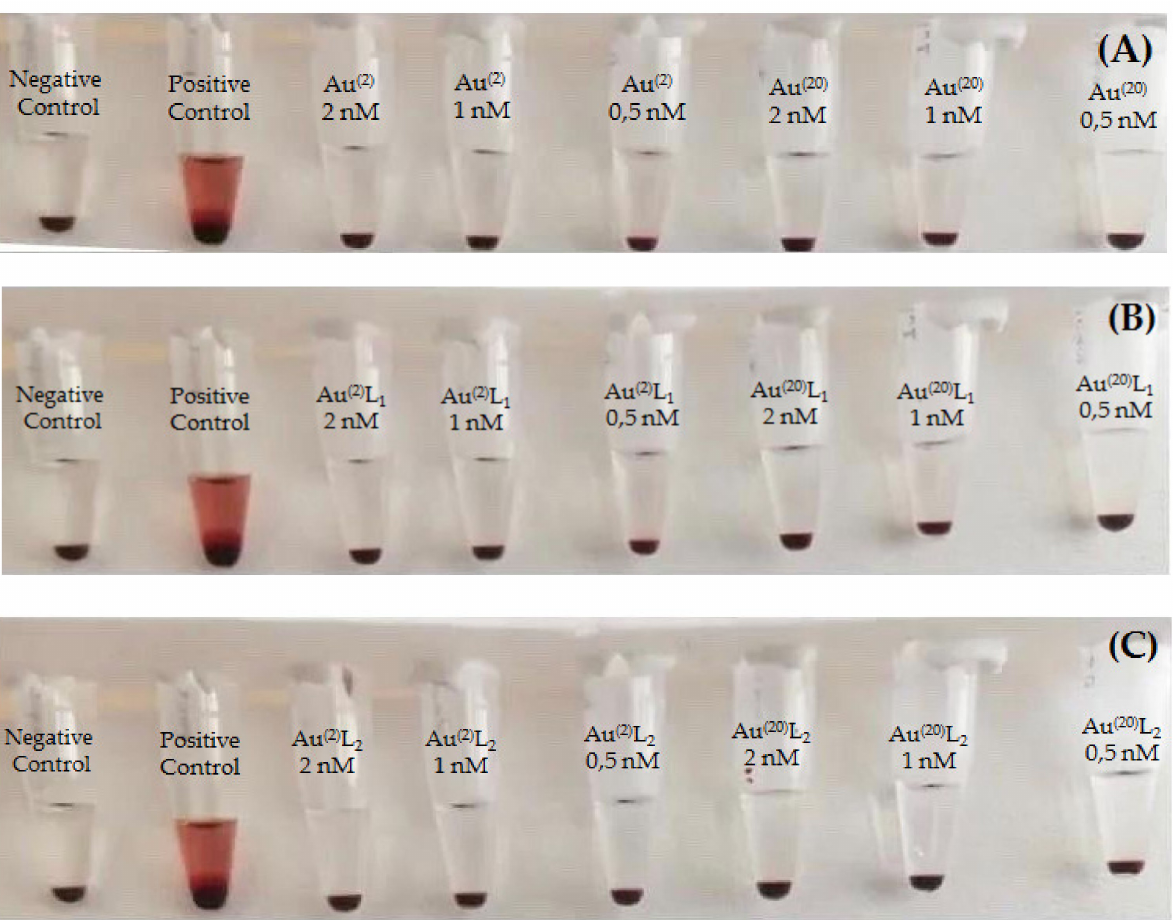
Figure 7. Hemolytic effect of: ( A ) Au (2) and Au (20) , ( B ) Au (2) L1 and Au (20) L1, and ( C ) Au (2) L2 and Au (20) L2 at different tested concentrations (0.5 nM, 1 nM, and 2 nM). Positive control: 10 µ L TRITON X 10% + 275 µ L PBS + 15 µ L of RBCs; negative control: 285 µ L PBS +15 µ L of